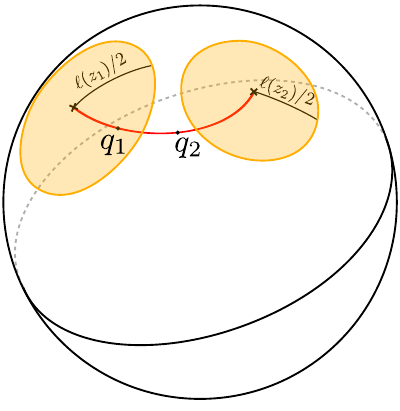
Figure 1 . The cuto(cid:11): the orange spherical caps should not overlap. Artist’s